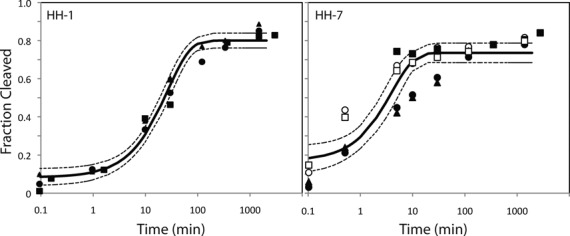
(Left) HH1: typical cleavage time series curve with good error parameters (standard deviation <10% of mean, with mean squared error (MSE) = 0.0029). Solid line represents fitted line, and dotted lines indicate 95% confidence interval. Different datasets represented by filled and unfilled squares, triangles, etc. (Right) HH7: fastest hammerhead cleavage rate, though determined with considerable error (MSE = 0.01). In data from the first experiments for HH7, indicated by filled squares, cleavage had been measured at times when maximum cleavage had nearly occurred (these points appear in the flat part of the fitted curve). Subsequent datasets have focused on shorter time periods. This curve was fitted using five datasets. Time series curves for cleavage data for the remaining eight designed hammerheads HH2-HH6 and HH8-HH10 are shown in Supplementary Information.